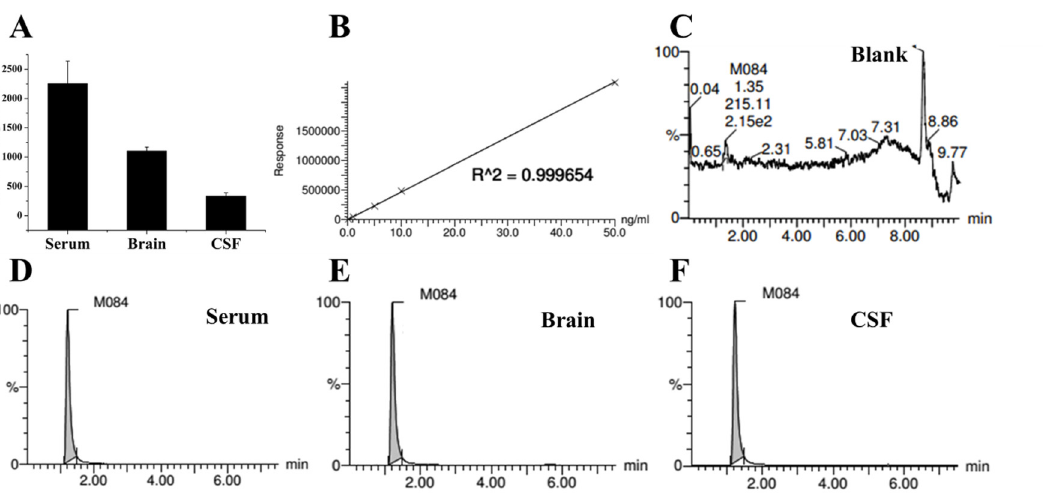
Fig 3. Distribution of M084 in serum, brain and CSF of mice. Serum, brain, and CSF samples were collected at 2 hours after treatment of M084 or vehicle. Concentrations of M084 were determined with LC-MS/MS analysis. (A) M084 can efficiently cross the blood-brain barrier at pharmacologically relevant doses (10 mg/kg, 2 hrs). Results are shown as mean ± SEM. (B) M084 calibration curve. Correlation coefficient = 0.999654, weighting factor = 1/x. (C-F) Representative LC – MS/MS chromatogram of blank brain sample, serum, brain and CSF,